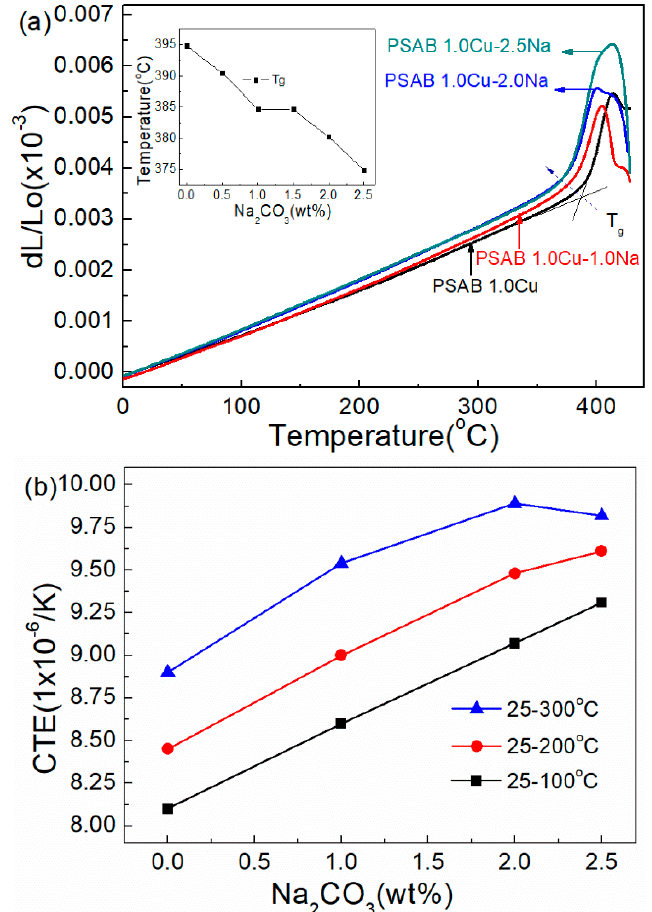
Figure 4. ( a ) TMA traces; and ( b ) variation of CTE for different temperature ranges, dependent on Na 2 CO 3 dopant concentration; inset shows the variation of T g , dependent on Na 2 CO 3 concentration.